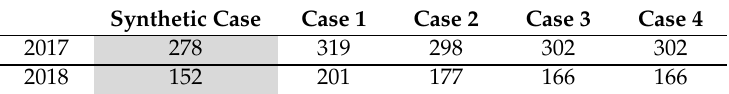
Table 3. Comparison of groundwater recharge values obtained for two simulation years (2017 and 2018) using di ff erent types of data in the optimization procedure. The set of reference soil hydraulic parameters is the “synthetic case”. To calibrate the model, the other cases rely on one water content profile at a single time (case 1); one water content profile and one pore water isotope composition profile at a same single time (case 2); monthly water content and pore water isotope composition monitoring at a 15 cm depth, plus one water content and pore water isotope composition profile at a single time (case 3); and daily water content monitoring at 10, 20, 50, and 100 cm depths, plus one water content and pore water isotope composition profile at a single time (case 4). Results are given in millimeters. Synthetic Case Case 1 Case 2 Case 3 Case 4 2017 278 319